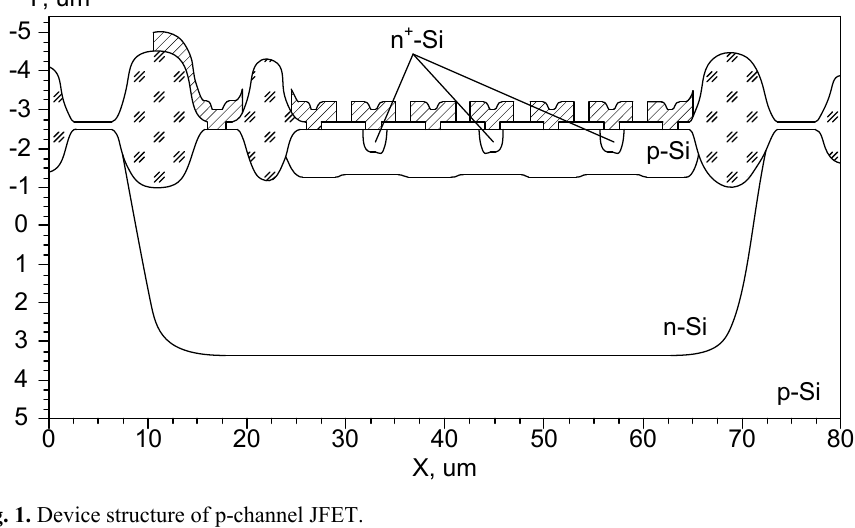
Fig. 1. Device structure of p-channel JFET.